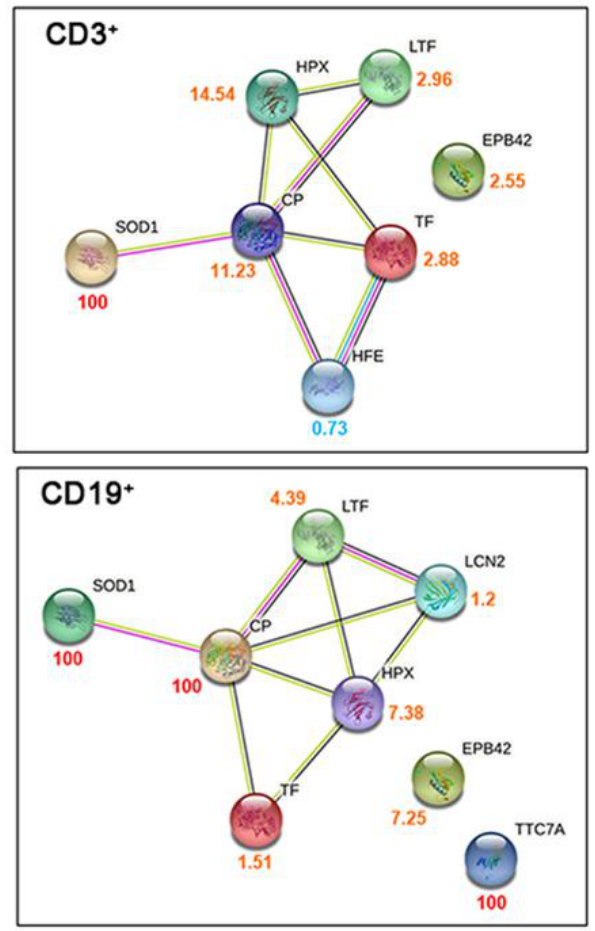
Figure 1. Characterization of proteome lymphocyte measurements taken from COVID-19 patients. Qualitative STRING networks from gene ontology analysis of the iron-related metabolism proteins quantified in CD3 + and CD19 + sorted lymphocytes. The numbers beside each protein represent the ratio between the protein abundance in COVID-19 patients and controls and are colored accordingly (red for proteins quantified only in COVID-19 patients, orange for proteins with higher abundance in COVID-19 patients, and light blue for proteins with higher abundance in controls).